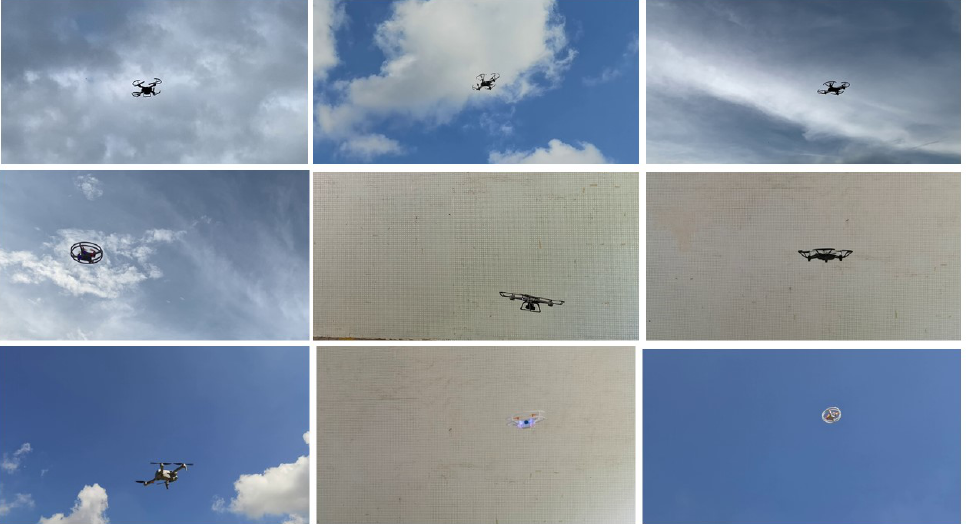
Figure 8. Original images of the UAV